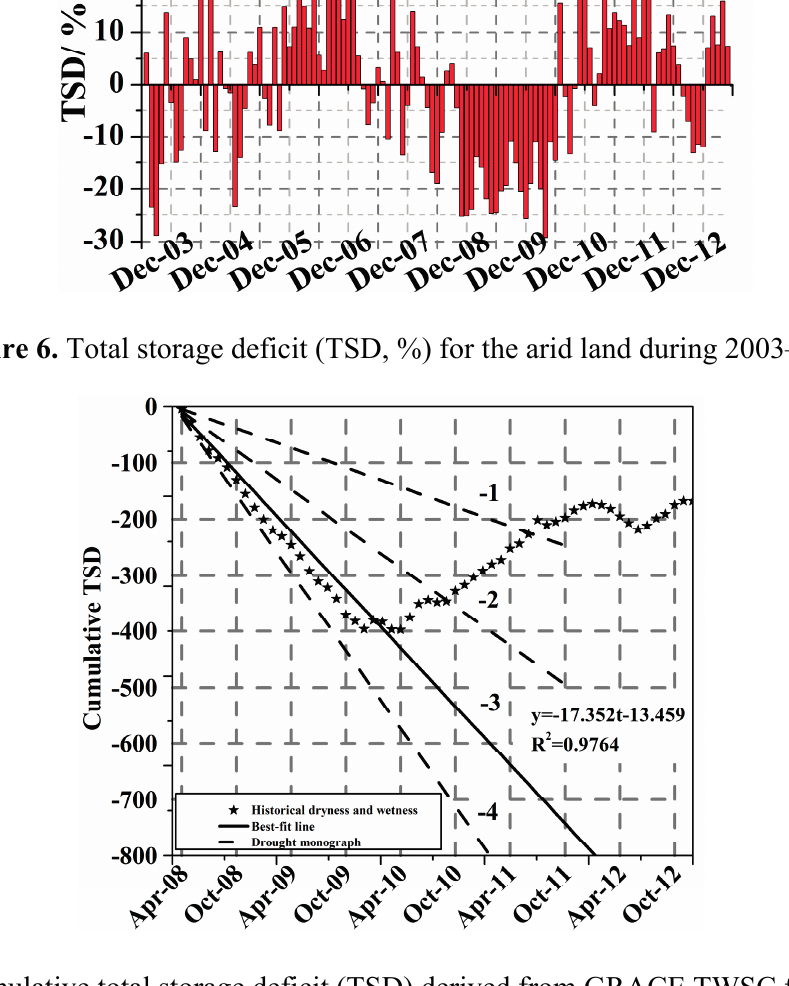
Figure 7. Cumulative total storage deficit (TSD) derived from GRACE TWSC for the arid